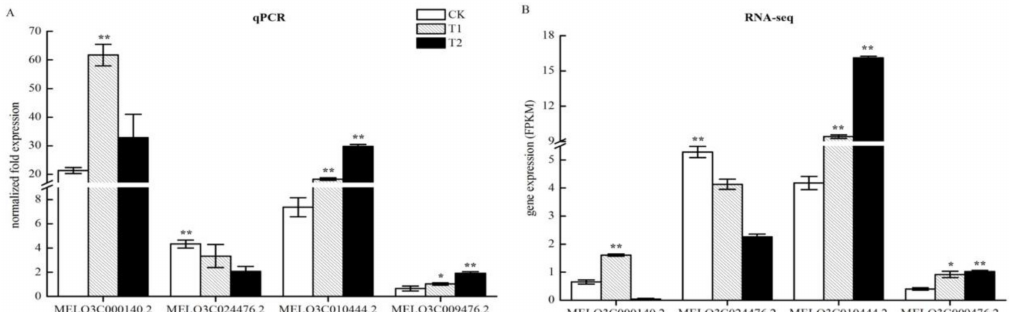
Figure 9. Quantitative real-time polymerase chain reaction (qPCR) analysis of di ff erential gene expression patterns in T1 and T2 compared with CK. ( A ) Validation of sequencing accuracy of T1 and T2 by qPCR analysis in nitrogen metabolism. The relative expression levels of three DEGs identified by RNA-seq analysis are shown in ( B ). The gene expression analysis was performed based on three biological and technical replicates, respectively. “**” and “*”: Significantly di ff erent at levels of 0.01 and 0.05 by Duncan’s multiple range test, respectively. The error bars represent the standard error (SE) of the